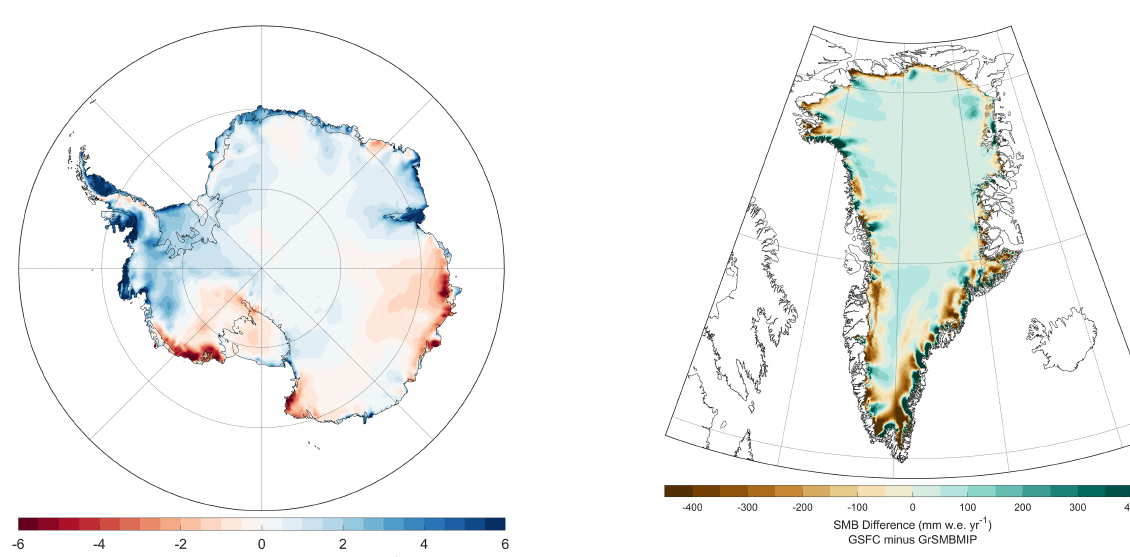
Figure 21. The difference in mean annual SMB between GSFC and the GrSMBMIP ensemble mean.